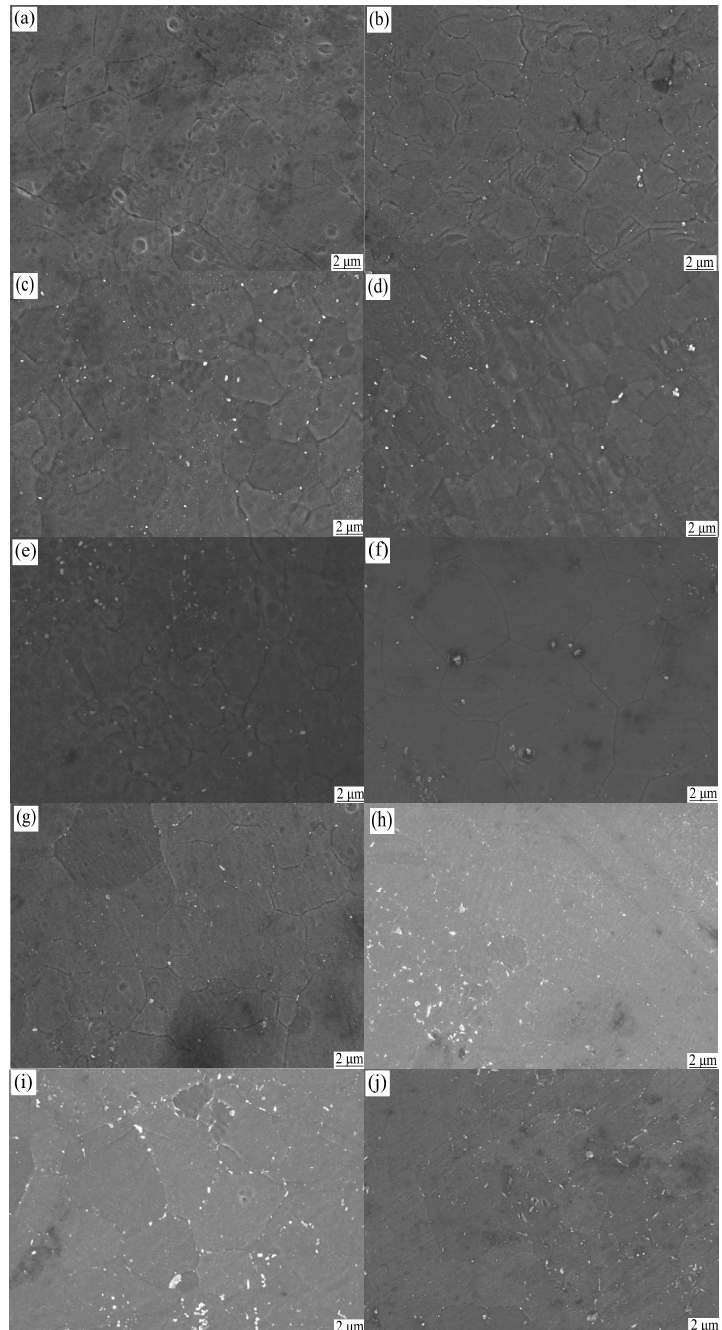
Figure 3. SEM of ZK60 magnesium alloy in heat treat state. ( a ) Hot rolled state; ( b ) at 170 ◦ C for 4 h; ( c ) at 170 ◦ C for 12 h; ( d ) at 170 ◦ C for 24 h; ( e ) at 190 ◦ C for 12 h; ( f ) at 400 ◦ C for 3 h; ( g ) at 400 ◦ C for 3 h and 170 ◦ C for 4 h; ( h ) at 400 ◦ C for 3 h and 170 ◦ C for 12 h; ( i ) at 400 ◦ C for 3 h and 170 ◦ C for 24 h; ( j ) at 400 ◦ C for 3 h and 190 ◦ C for 12